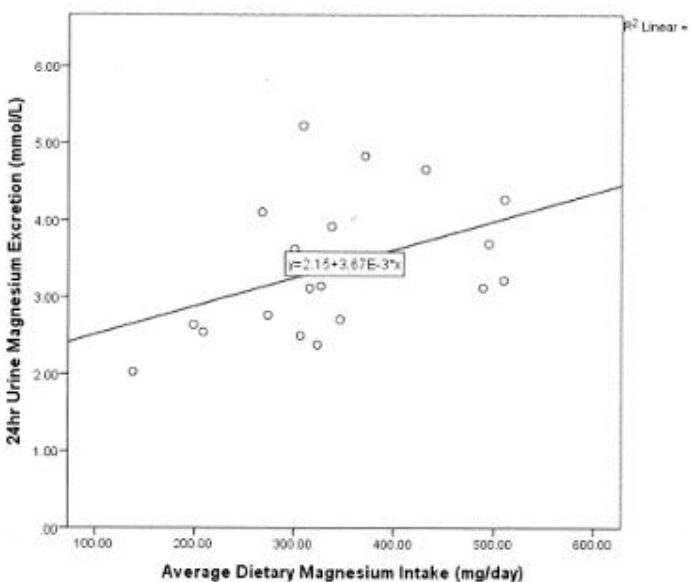
Figure 2. Association between Urinary and Dietary Magnesium.